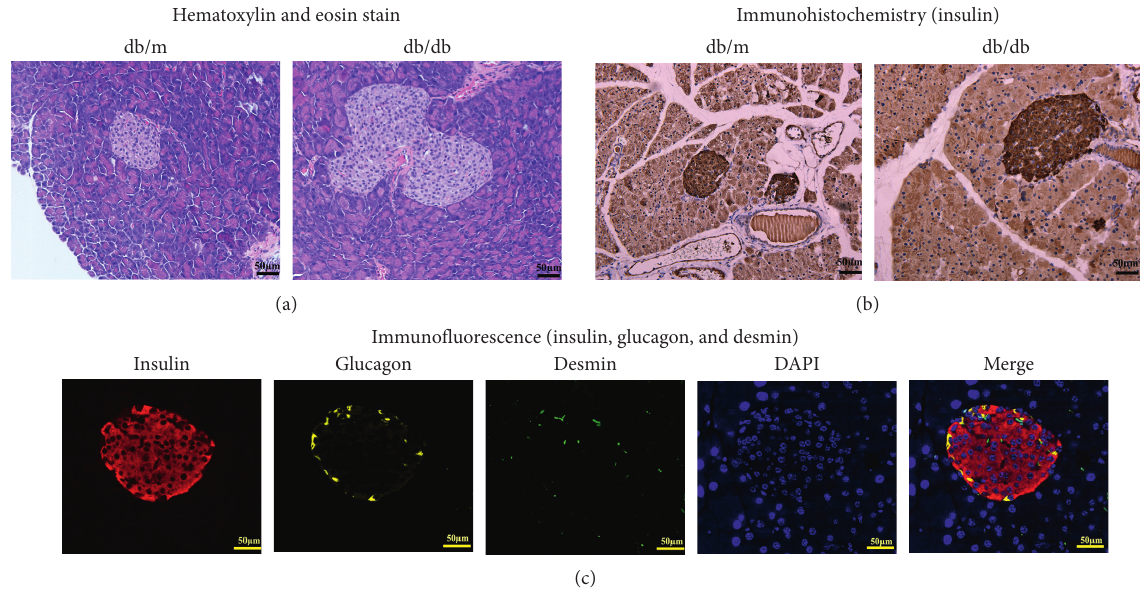
Figure 2: Expression of insulin, glucagon, and desmin in the islets. (a) Hematoxylin and eosin staining of pancreas tissue sections (scale bar � 50 μ m). (b) Paraffin-embedded sections of db/m and db/db mouse pancreases showing the expression of insulin as determined by im- munohistochemistry (scale bar � 50 μ m). (c) Immunofluorescence staining of islet for insulin, glucagon, desmin, and DAPI (scale bar � 50 μ